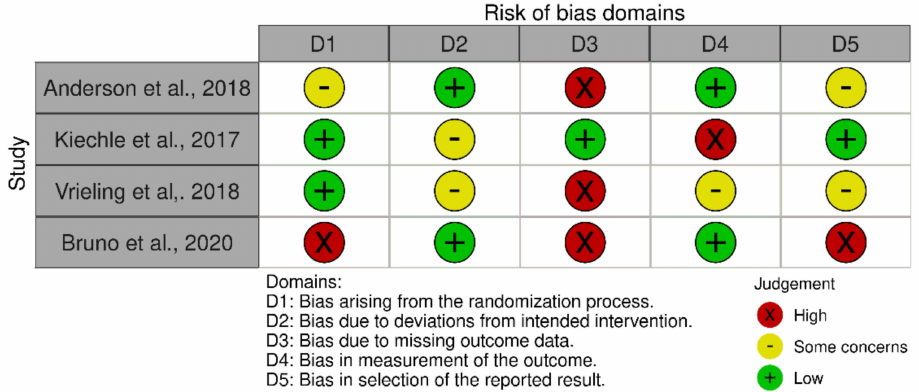
Figure 4. Risk of bias of included studies [14] Studies: Anderson et al. [38], Kiechle et al. [37], Vrieling et al. [40] and Bruno et al.